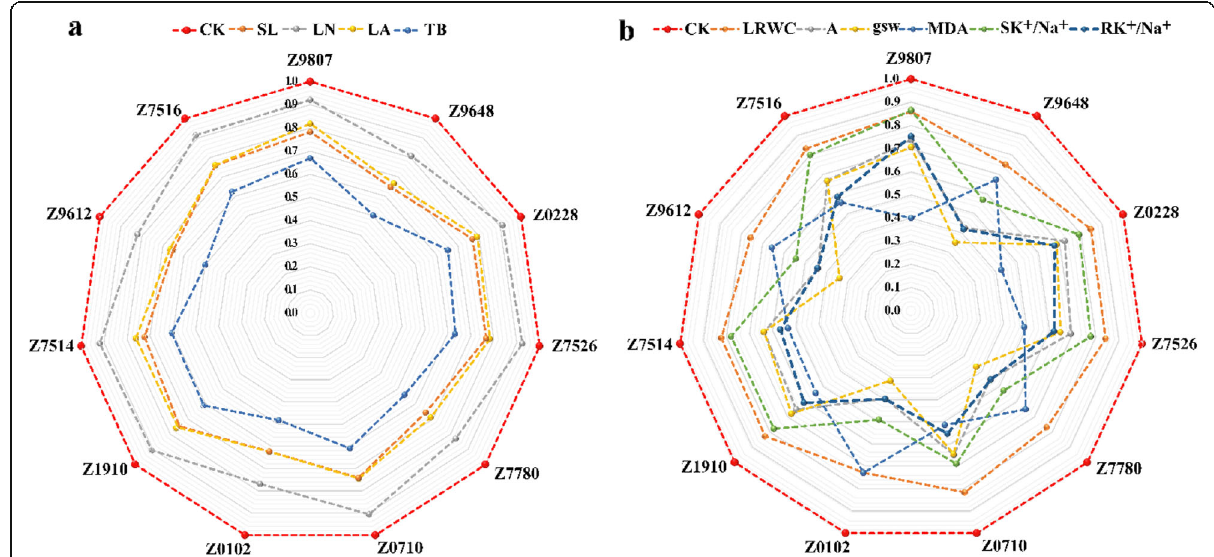
Fig. 3 Radar plot represents the genotypic variations in different morphological ( a ) and physiological ( b ) traits in the presence of 200 mmol·L − 1 NaCl treatment